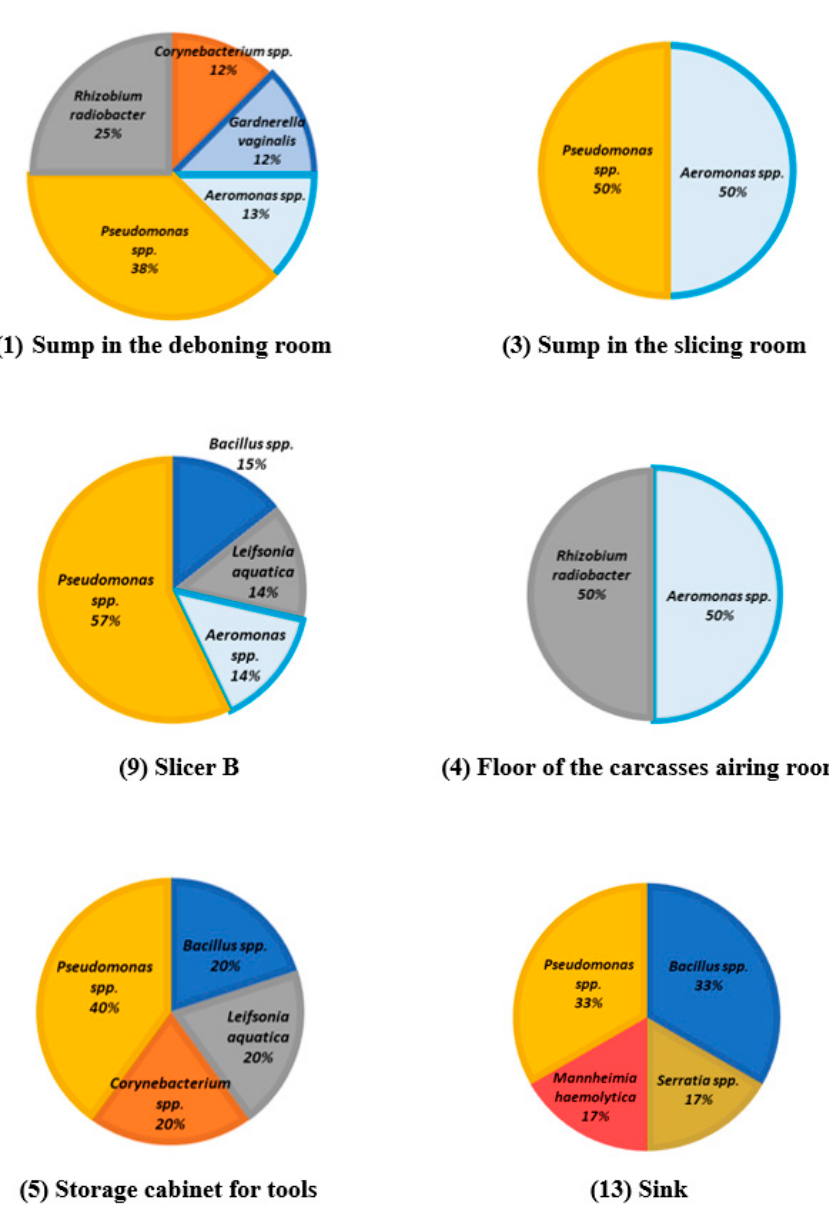
Figure 3. Individual profiles of the areas categorized as cluster 1. Pseudomonas spp. was predominant in most areas and there was also a notable presence of Aeromonas spp.